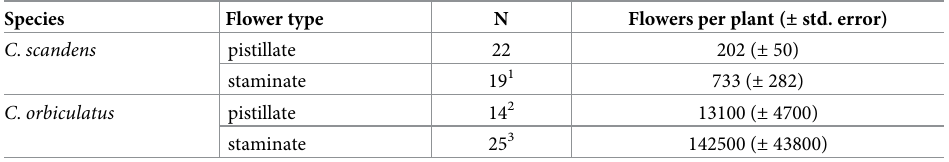
Table 1. Estimated total annual flower production.